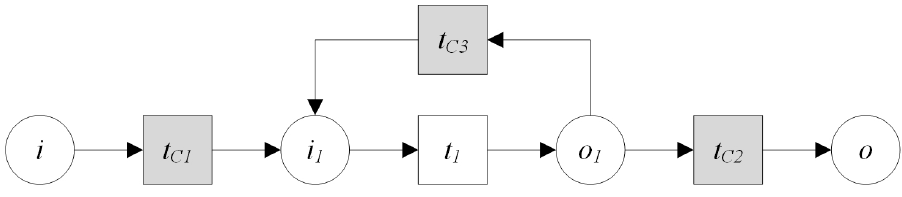
Figure 11. Iteration operation.